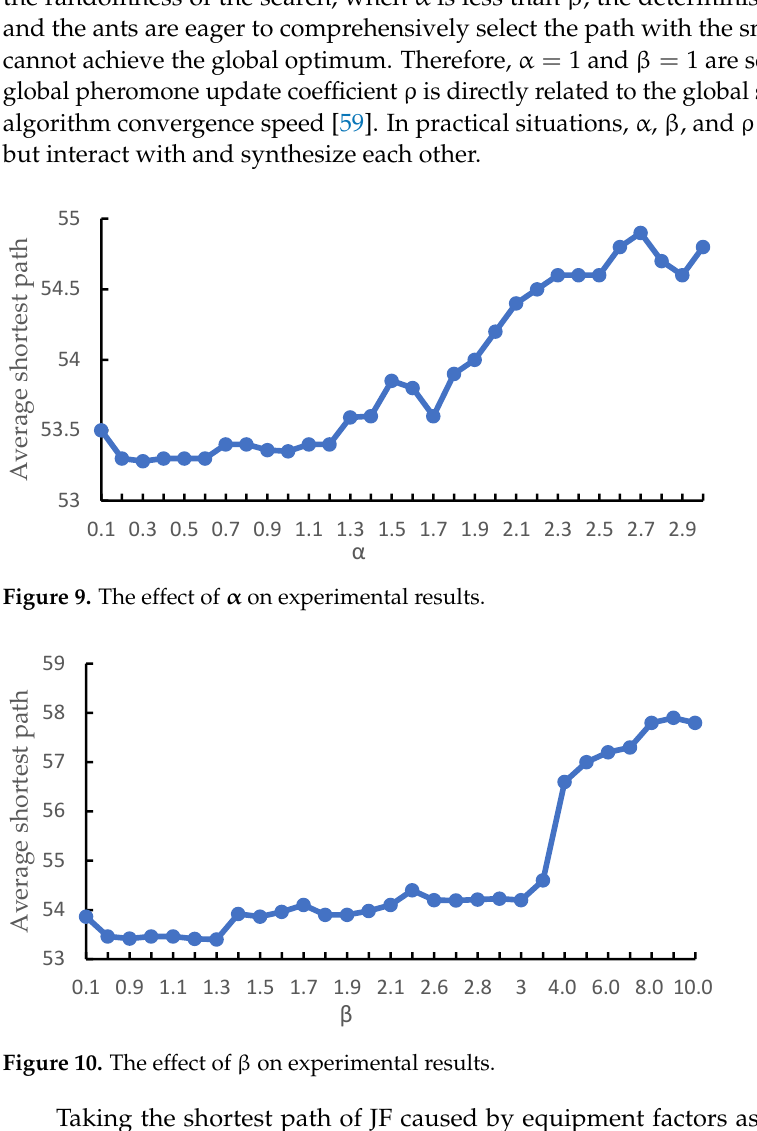
Figure 11. Shortest path comparison chart.